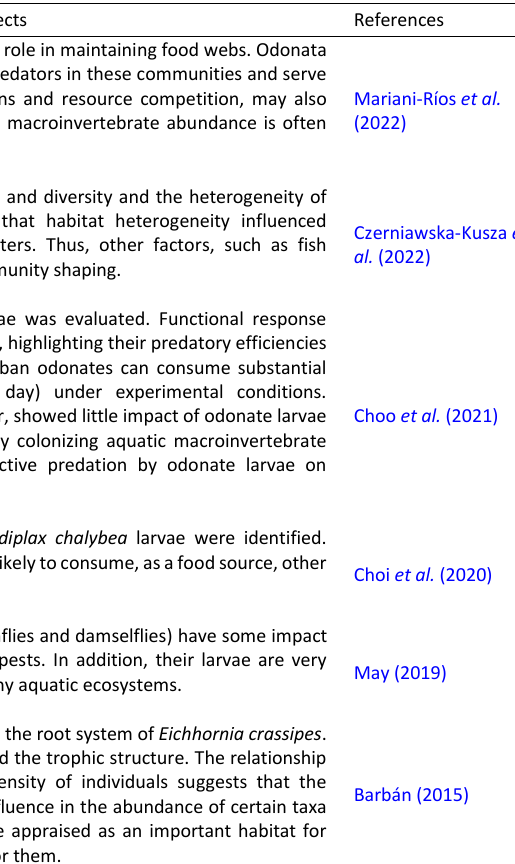
Table 1: Summary of recent studies about Odonata´s relationship with macroinvertebrates